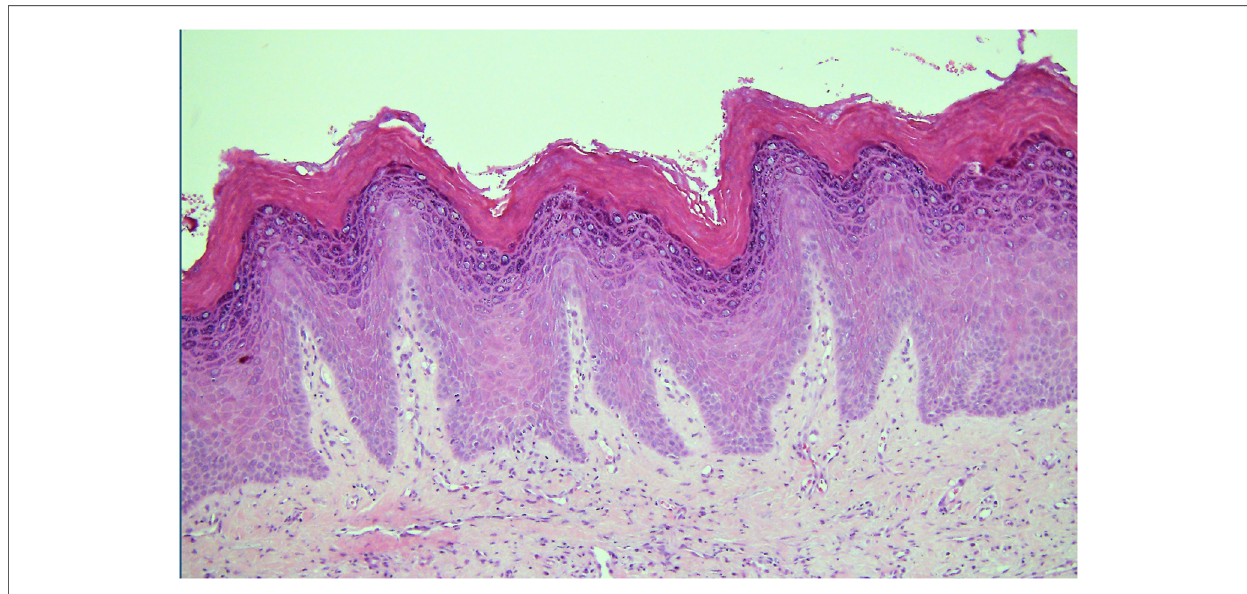
FIGURE 2 Photomicrograph from a biopsy of a white patch on the maxillary buccal gingiva in a 56 year old female. The surface epithelium is hyperplastic with a verruciform architecture. Despite the absence of cellular atypia this pattern can be associated with a higher risk of malignant transformation than a fl at lesion with the same degree of cellular changes.